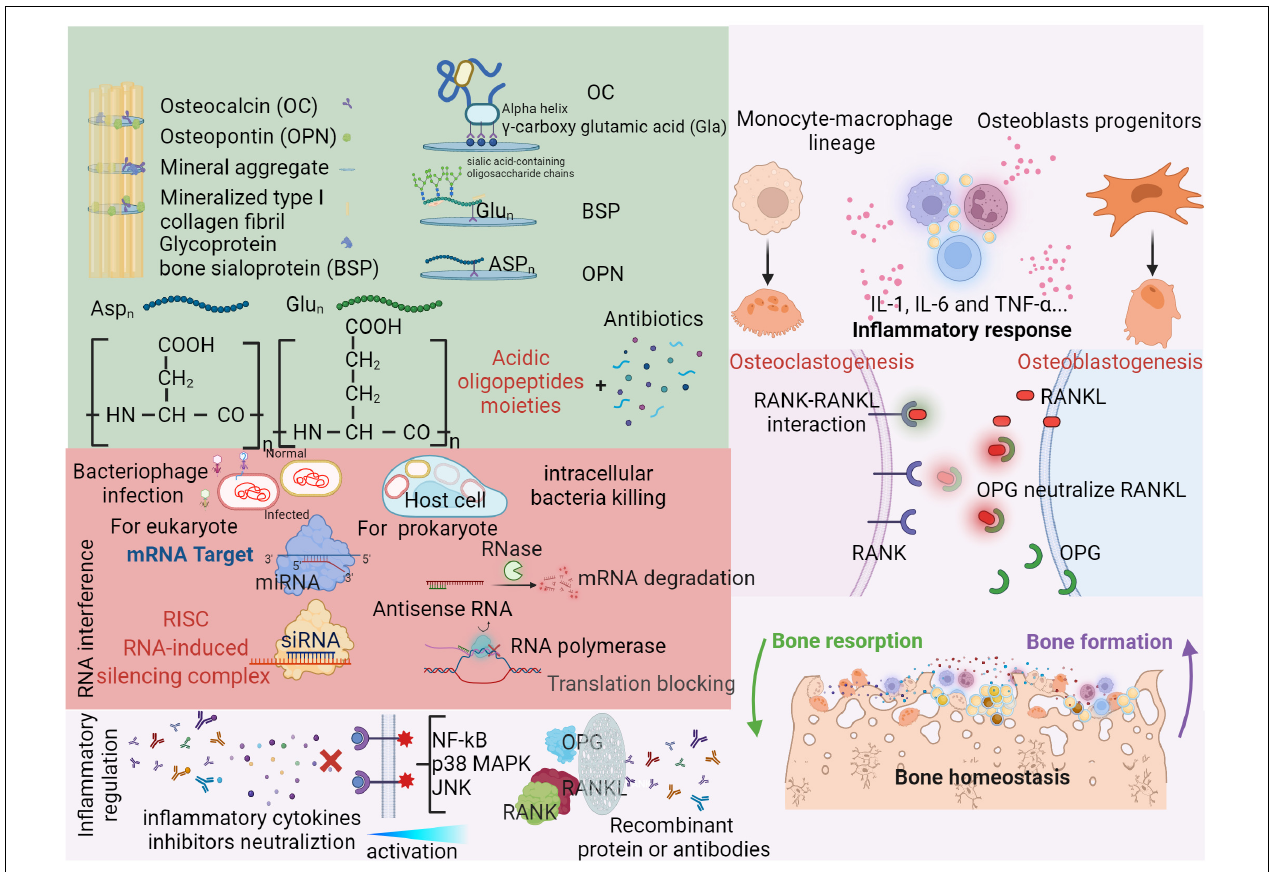
three neighboring γ -carboxy glutamic acid (Gla) residues on the same face of the alpha helix, osteocalcin (OC) can bind with mineral aggregate (Stock, 2015). RNA interference (RNAi) is effectiveness in transcriptive level as a novel administration. For bacterial elimination, antisense RNA can recruit RNase to degrade base-paired mRNA and repel RNA polymerase to block translation (Quemener et al., 2022). Similarly, miRNA and siRNA can form RNA-induced silencing complex intraocularly for eukaryote, which are enable to modulate bone homeostasis (Jinek and Doudna, 2009). Bacteriophages can specifically and continually infect bacterial even